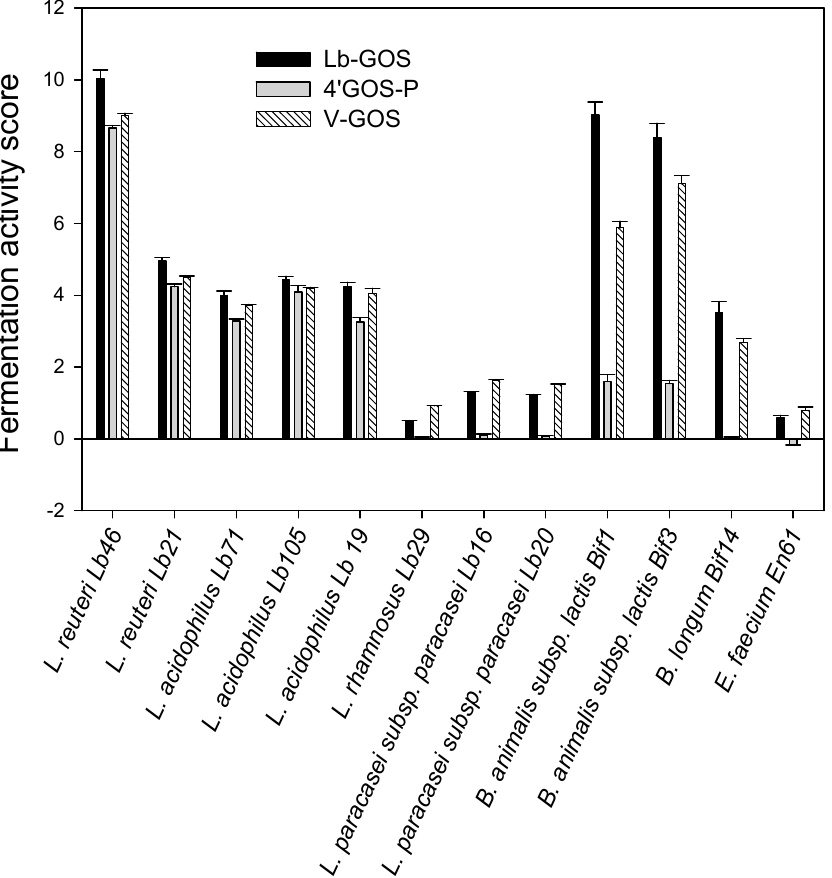
Figure 2. Fermentation activity scores (FAS), calculated by using Equation (1), for various strains of Bifidobacterium and Lactobacillus grown on different prebiotic galacto-oligosaccharide mixtures at 37 °C and for 24 h. Lb-GOS, galacto-oligosaccharides produced by β -galactosidase from Lactobacillus sp.; 4 ′ GOS-P, β 1 → 4 linked galacto-oligosaccharides; V-GOS, Vivinal galacto-oligosaccharides